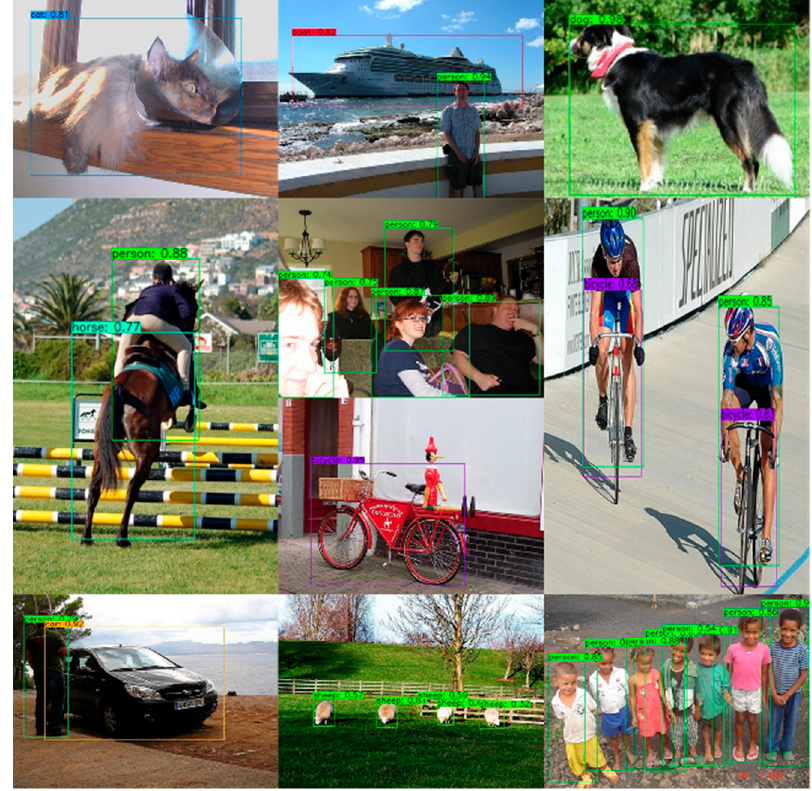
Figure 7. Partial test results of Mixed YOLOv3-LITE using the PASCAL VOC 2007 test set. Table 7. Evaluation results for baseline models and Mixed YOLOv3-LITE for VisDrone